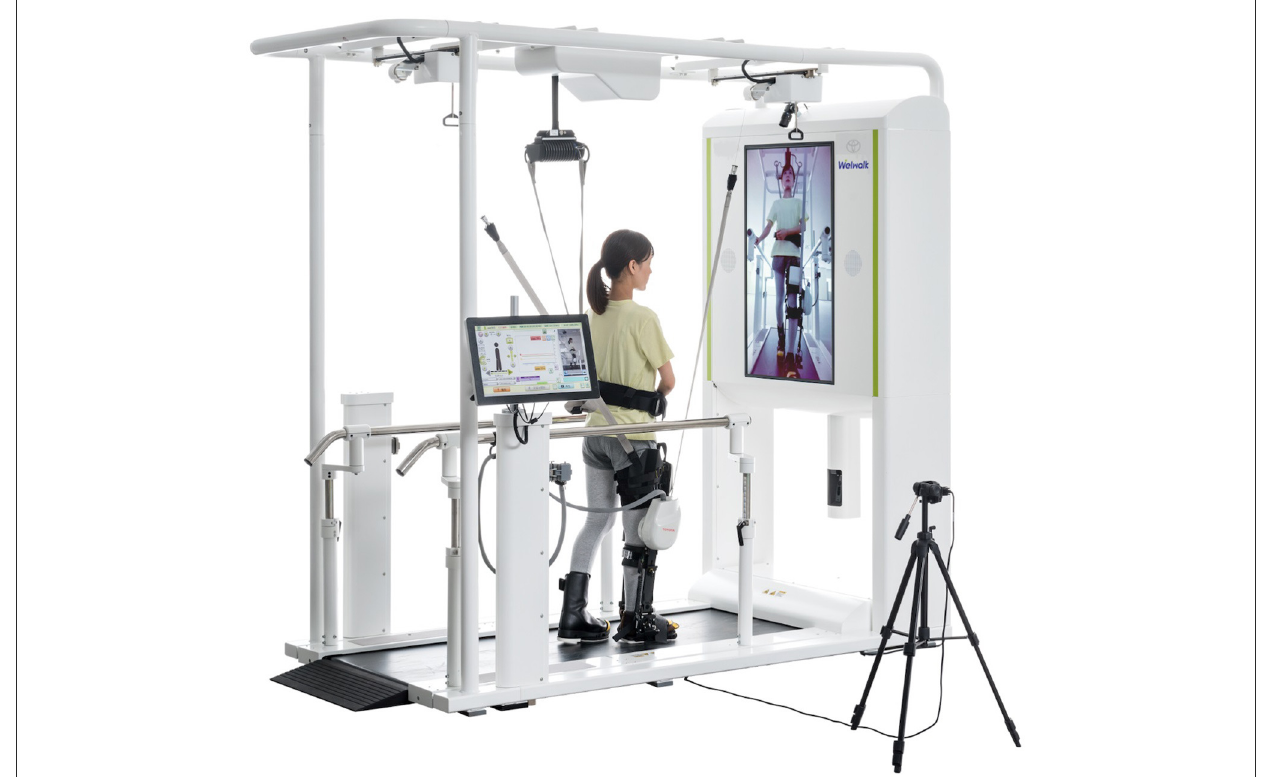
FIGURE1 Welwalk WW-2000. The figure is published with consent from Toyota Motor